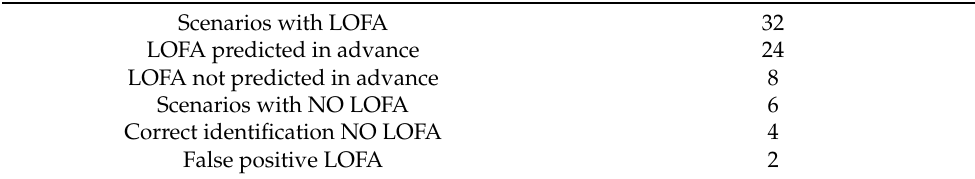
Table 2. LOFA identification results on N test = 38 scenarios. Scenarios with LOFA 32 LOFA predicted in advance LOFA not predicted in